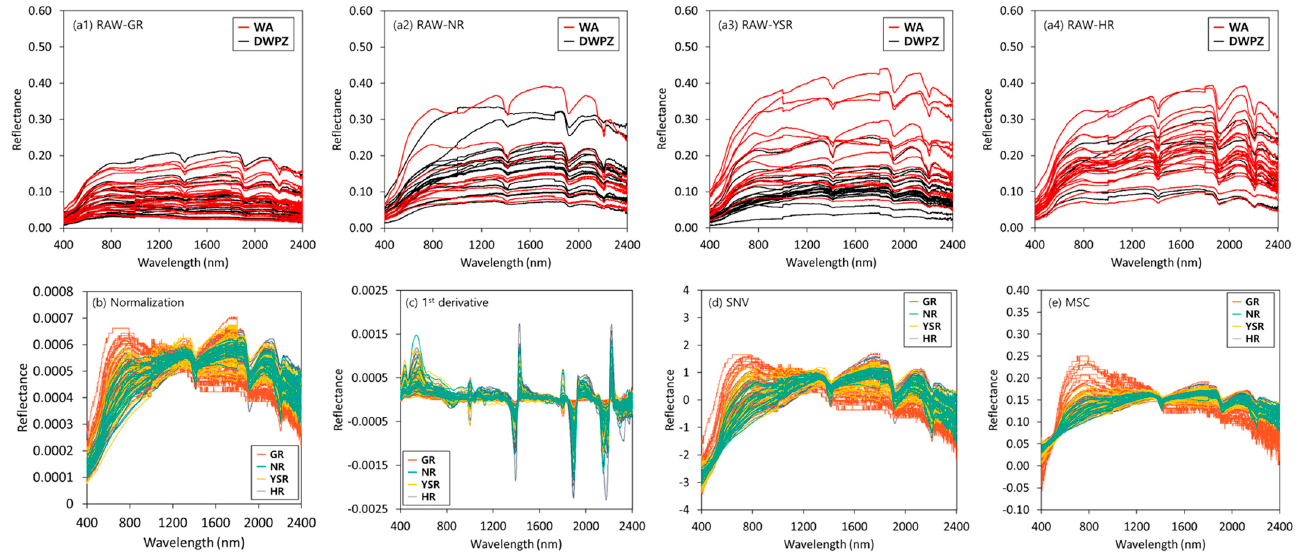
Figure 4. ( a ) Raw reflection spectrum of topsoil samples in ( a1 ) Geum River, ( a2 ) Nakdong River, ( a3 ) Yeongsan/Seomjin River, and ( a4 ) Han River and reflection spectrum with applied main pre- processing (( b ) maximum normalization, ( c ) 1st derivative, ( d ) SNV, and ( e ) MSC).